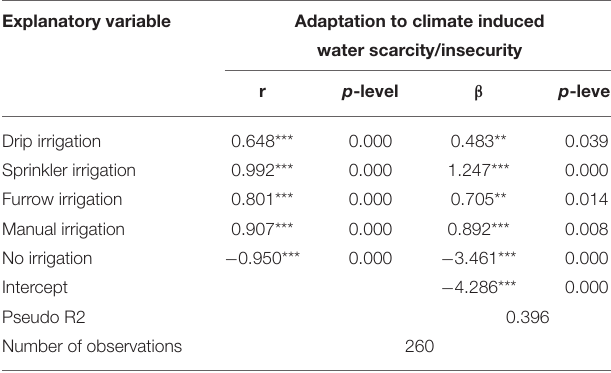
TABLE 6 | Determinants of markets gardeners’ adoption of irrigation practices faced with extreme weather/climate events inducing water insecurity. Explanatory